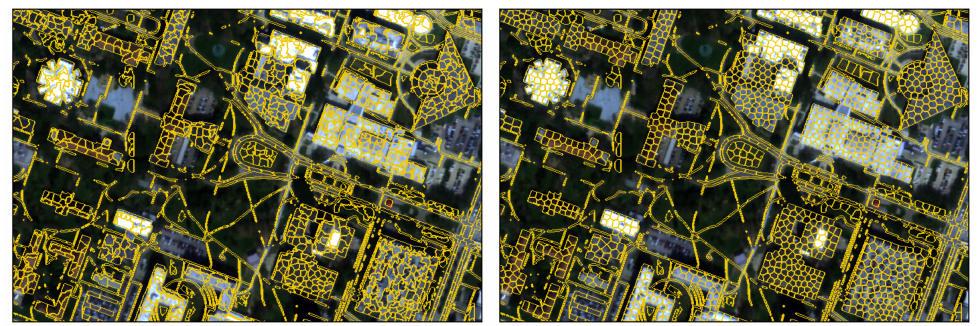
Figure 8. Difference between the segmentation obtained after PCA and panchromatic dimensionality reduction